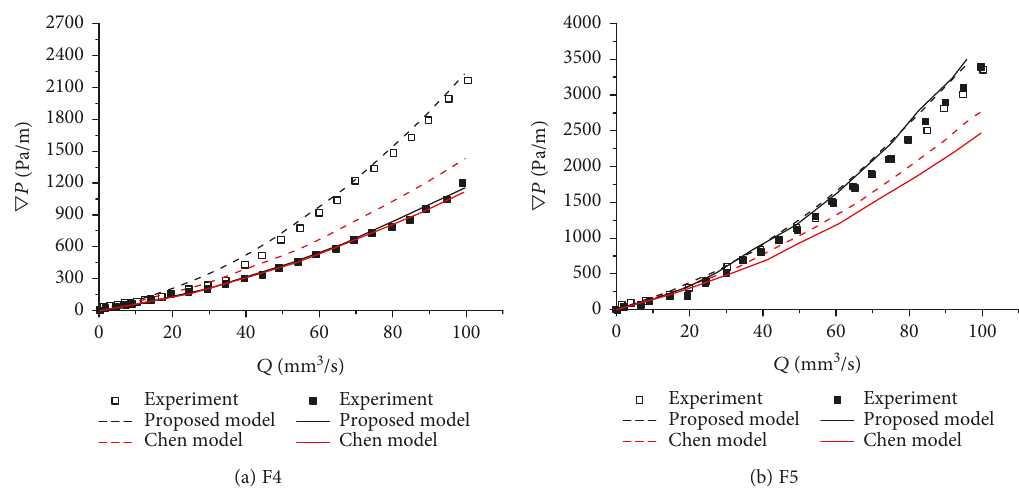
Figure 8: Comparison of results from equation (21), equation (22), and experimental measurements (open point is fl ow test along the 0 ° direction and solid point is fl ow test along the 90 ° direction; dashed line and solid line are proposed and the Chen model in 0 ° and 90 ° directions,